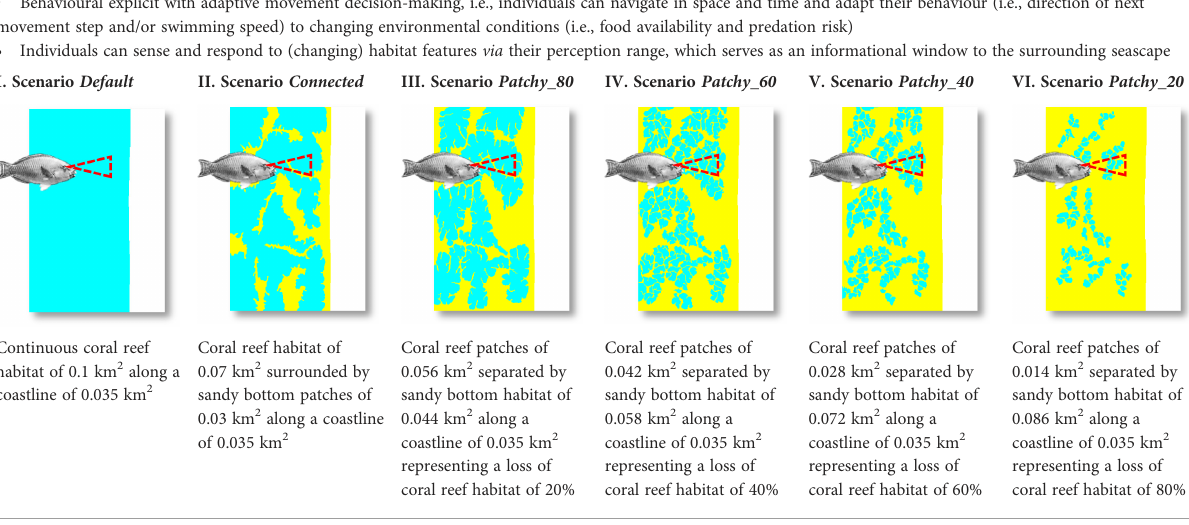
TABLE 1 Overview of tested scenarios with six alternative seascape settings (I-VI). Movement strategy PERCEPTION (movement algorithm based on potential fi